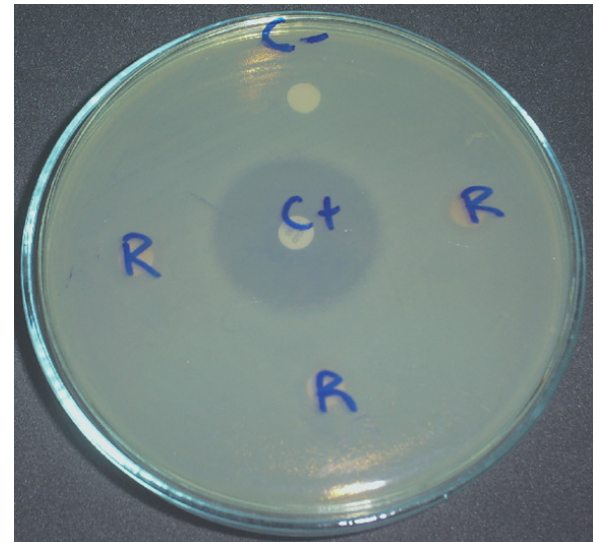
Figura 2. Placa de Petri com halo de inibição do crescimento microbiano em relação ao disco impregnado com cloranfenicol 30 μg (controle positivo, C+), discos com o extrato em três repetições (100 μg cada disco, R) e disco com água destilada (controle negativo,